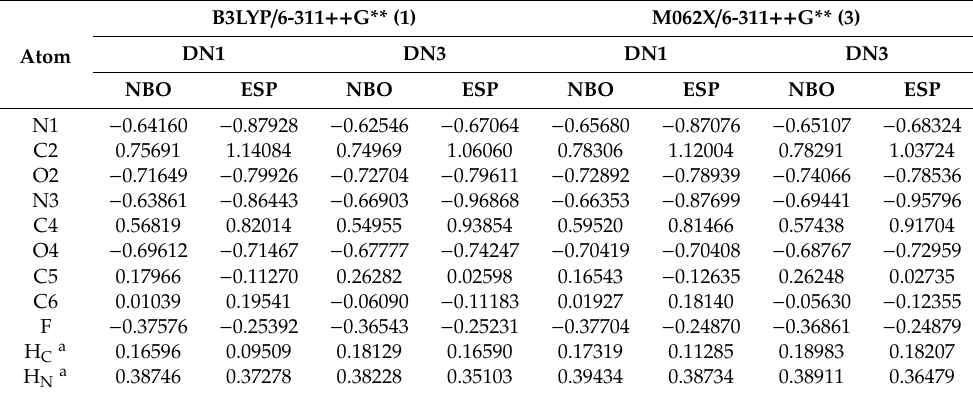
Table 3. The charge distribution in the DN1 and DN3 anions from NBO and ESP analyses.